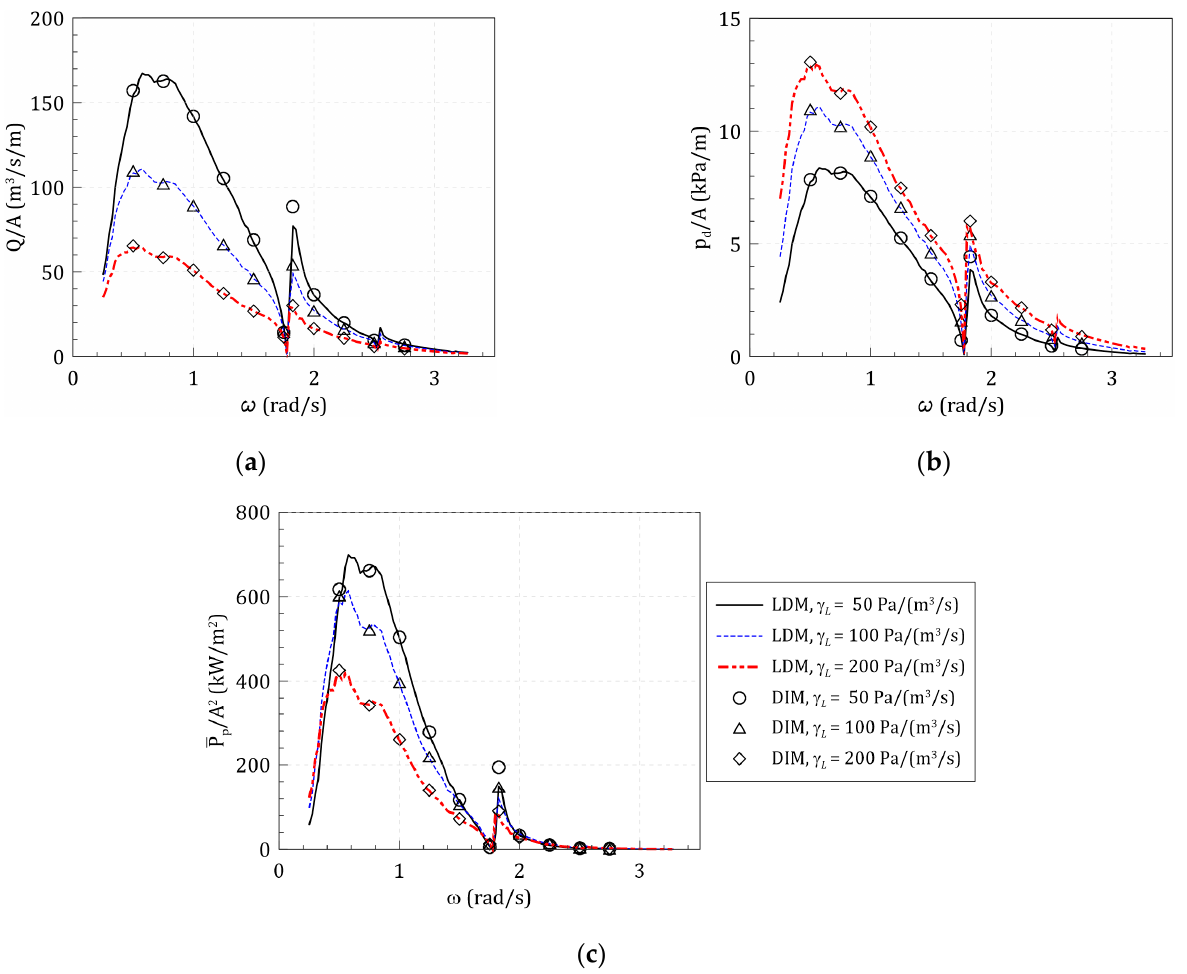
Figure 14. Comparison of numerical results between the linear decomposition method and direct interaction method under various wave frequencies: ( a ) airflow; ( b ) pressure drop; ( c ) pneumatic power.